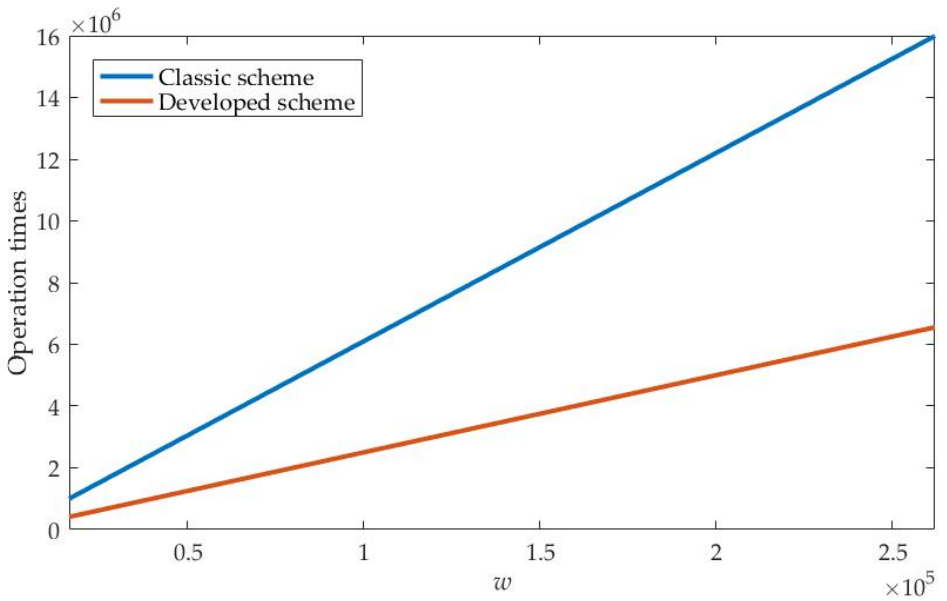
Figure 4. Comparison of the number of operations performed by the two schemes with respect to changes in w.